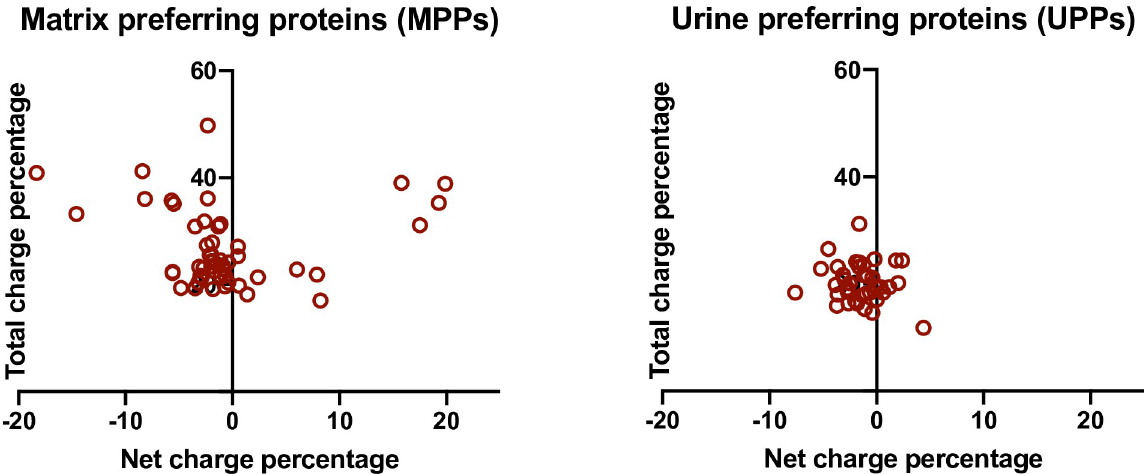
Fig 1. Cluster plots of total charge percentage vs. net charge percentage. Matrix preferring proteins (MPP) are shown in the left hand panel, and urine preferring proteins (UPP) are shown in the right hand panel. Many more proteins with both high total charge percentage and extreme net charge percentage were observed in the MPP set than in the UPP